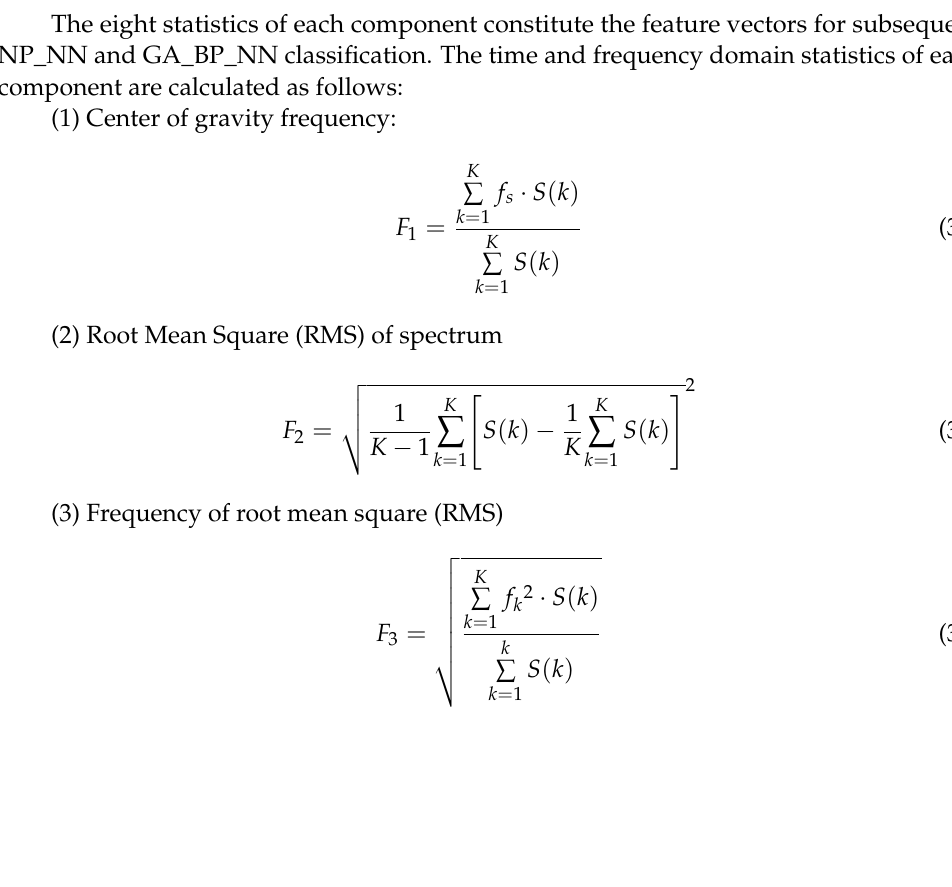
Table 2. Expected output of neural network corresponding to each state of centrifugal pump.